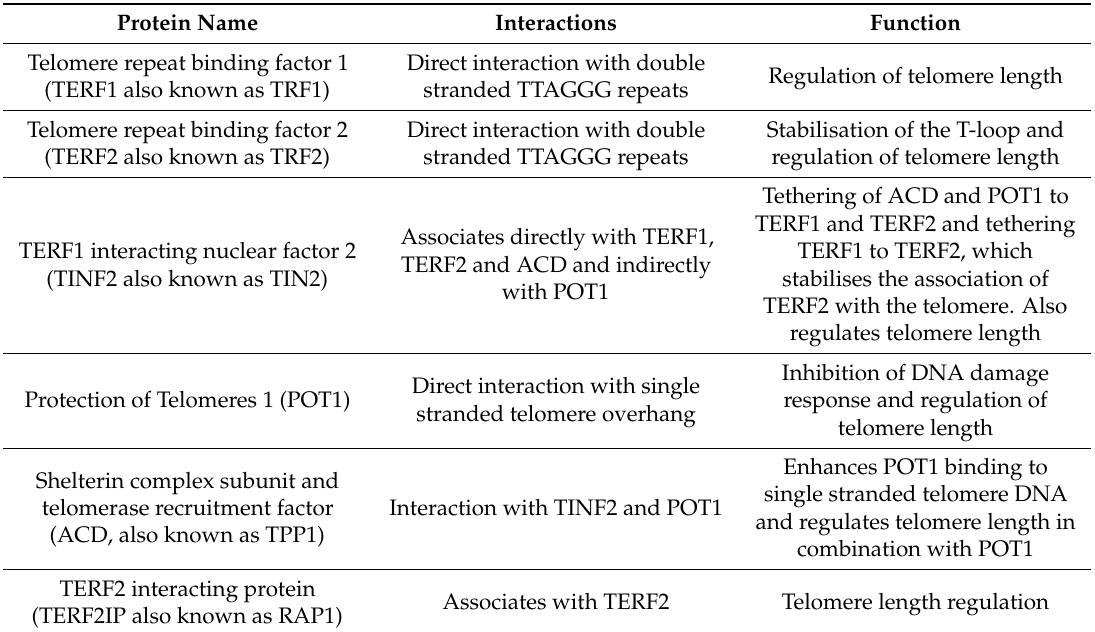
Figure 1. The T-loop and the D-loop. The 3 ′ end of the G rich strand (blue) protrudes as a single stranded extension of the telomere. This G-strand overhang loops back to form a T-loop and invades the 5 ′ double stranded telomeric duplex, forming a D-loop. Table 1. The Shelterin complex: Characterisation of the proteins that make up the Shelterin complex [3,11,12].